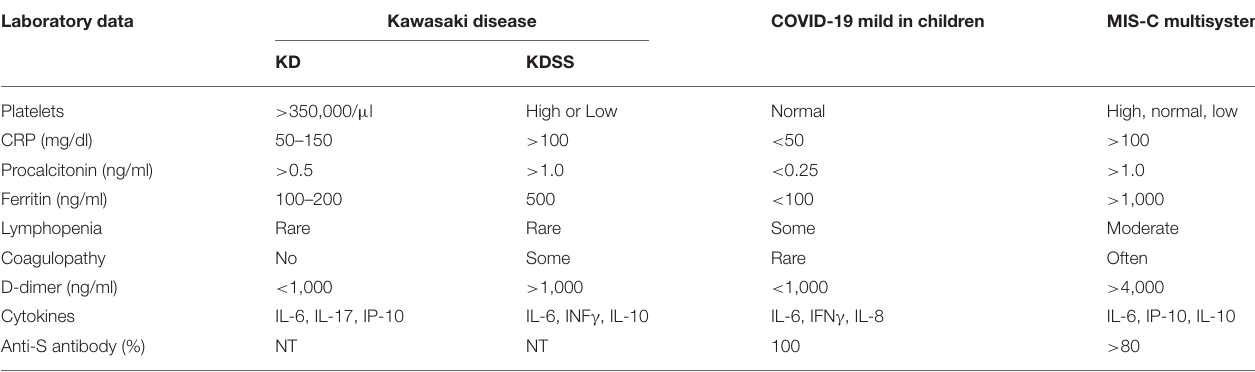
TABLE 2 | Laboratory data of KD, COVID-19, and